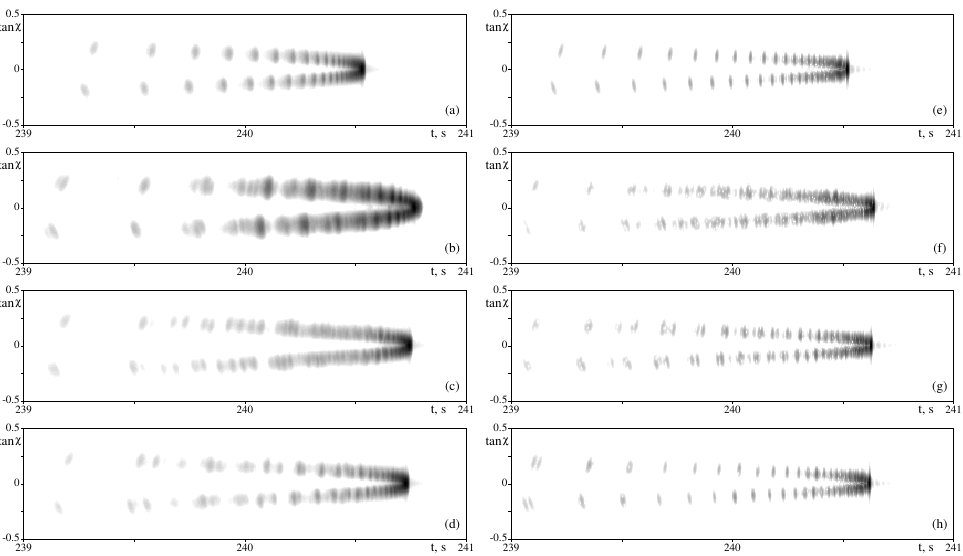
Figure 3. The same as in Figure 2, but for the case of ∆ z = 30 m. Figures ( a – d ) correspond to averaging over 100 realizations of internal waves. Figures ( e – h ) correspond to the model of a waveguide without internal waves. Panels ( a – e )—waveguide without the eddy, panels ( b – f )—the eddy core at z e = 600 m, panels ( c – g )—the eddy core at z e = 1000 m, panels ( d – h )—the eddy core at z e = 1500